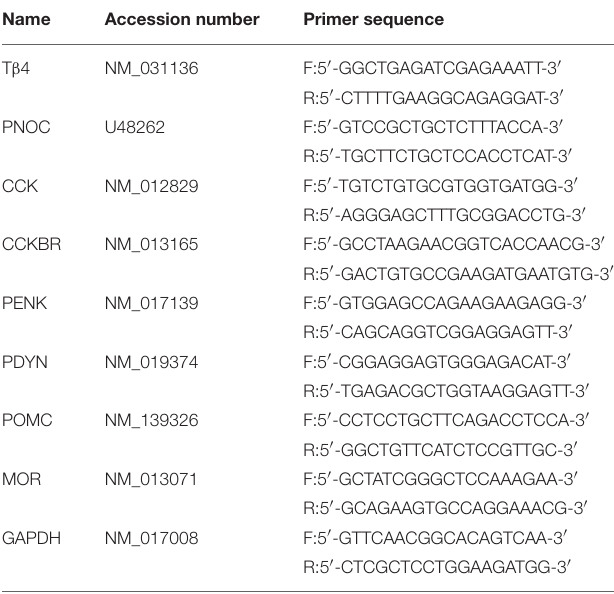
TABLE 1 | Primer sequences of opioid- and anti-opioid peptide and related receptor